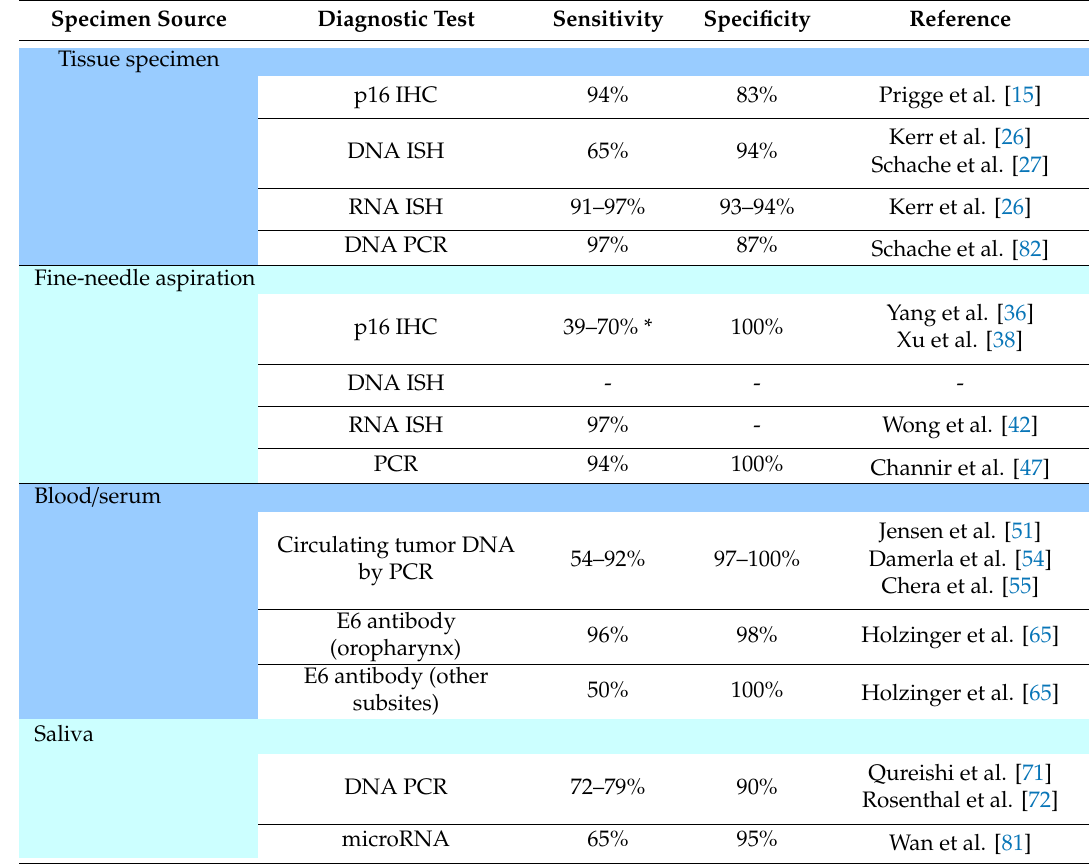
Table 1. Test characteristics for detection of HPV in head and neck squamous cell carcinomas